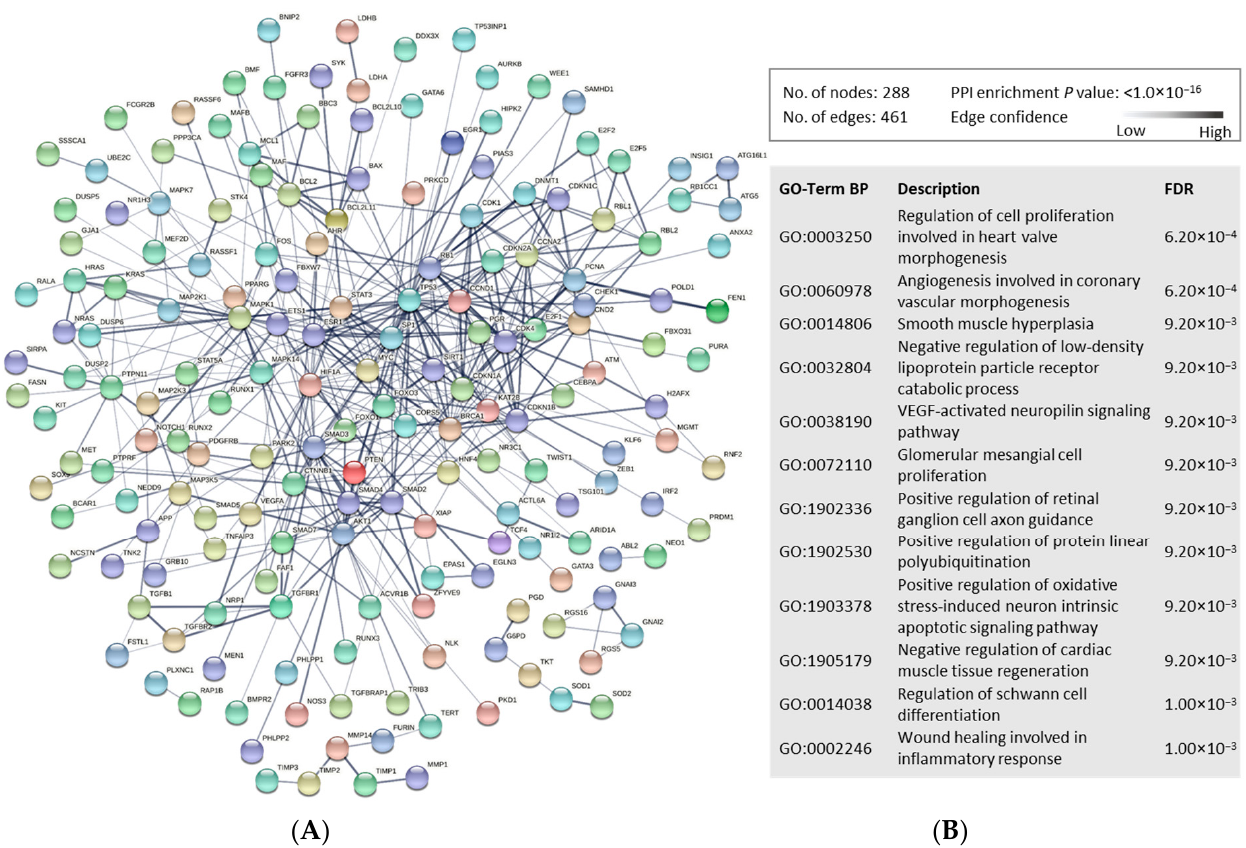
Figure 4. Functional enrichment analysis of the proteins encoded by the gene targets of dysregulated miRNAs in AIS versus TIA patients. ( A ). The protein–protein interaction (PPI) network generated for the 345 gene targets (unique genes; n = 292, protein coding genes; n = 288) of the identified miRNA panel is shown. Network nodes represent proteins, while edges depict protein–protein associations. They key network statistics are also presented. ( B ). The top functional enrichment annotations from Gene Ontology (GO) Biological Process are listed.